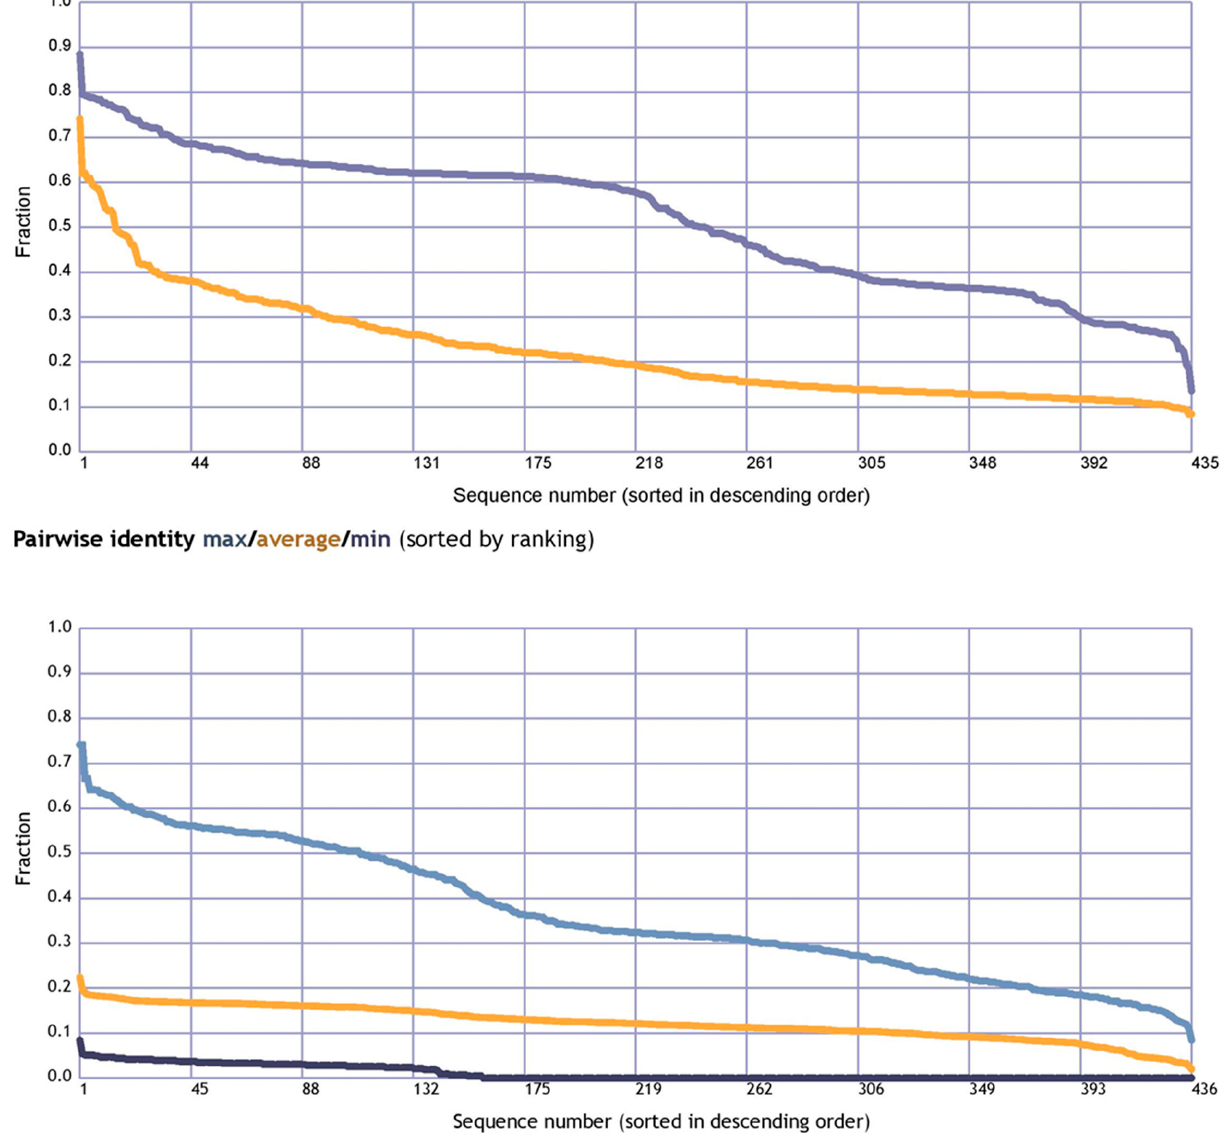
Figure 5. Utilizing evolutionary data from multiple sequence alignments, RePROF predicted solvent accessibility and secondary structure elements.